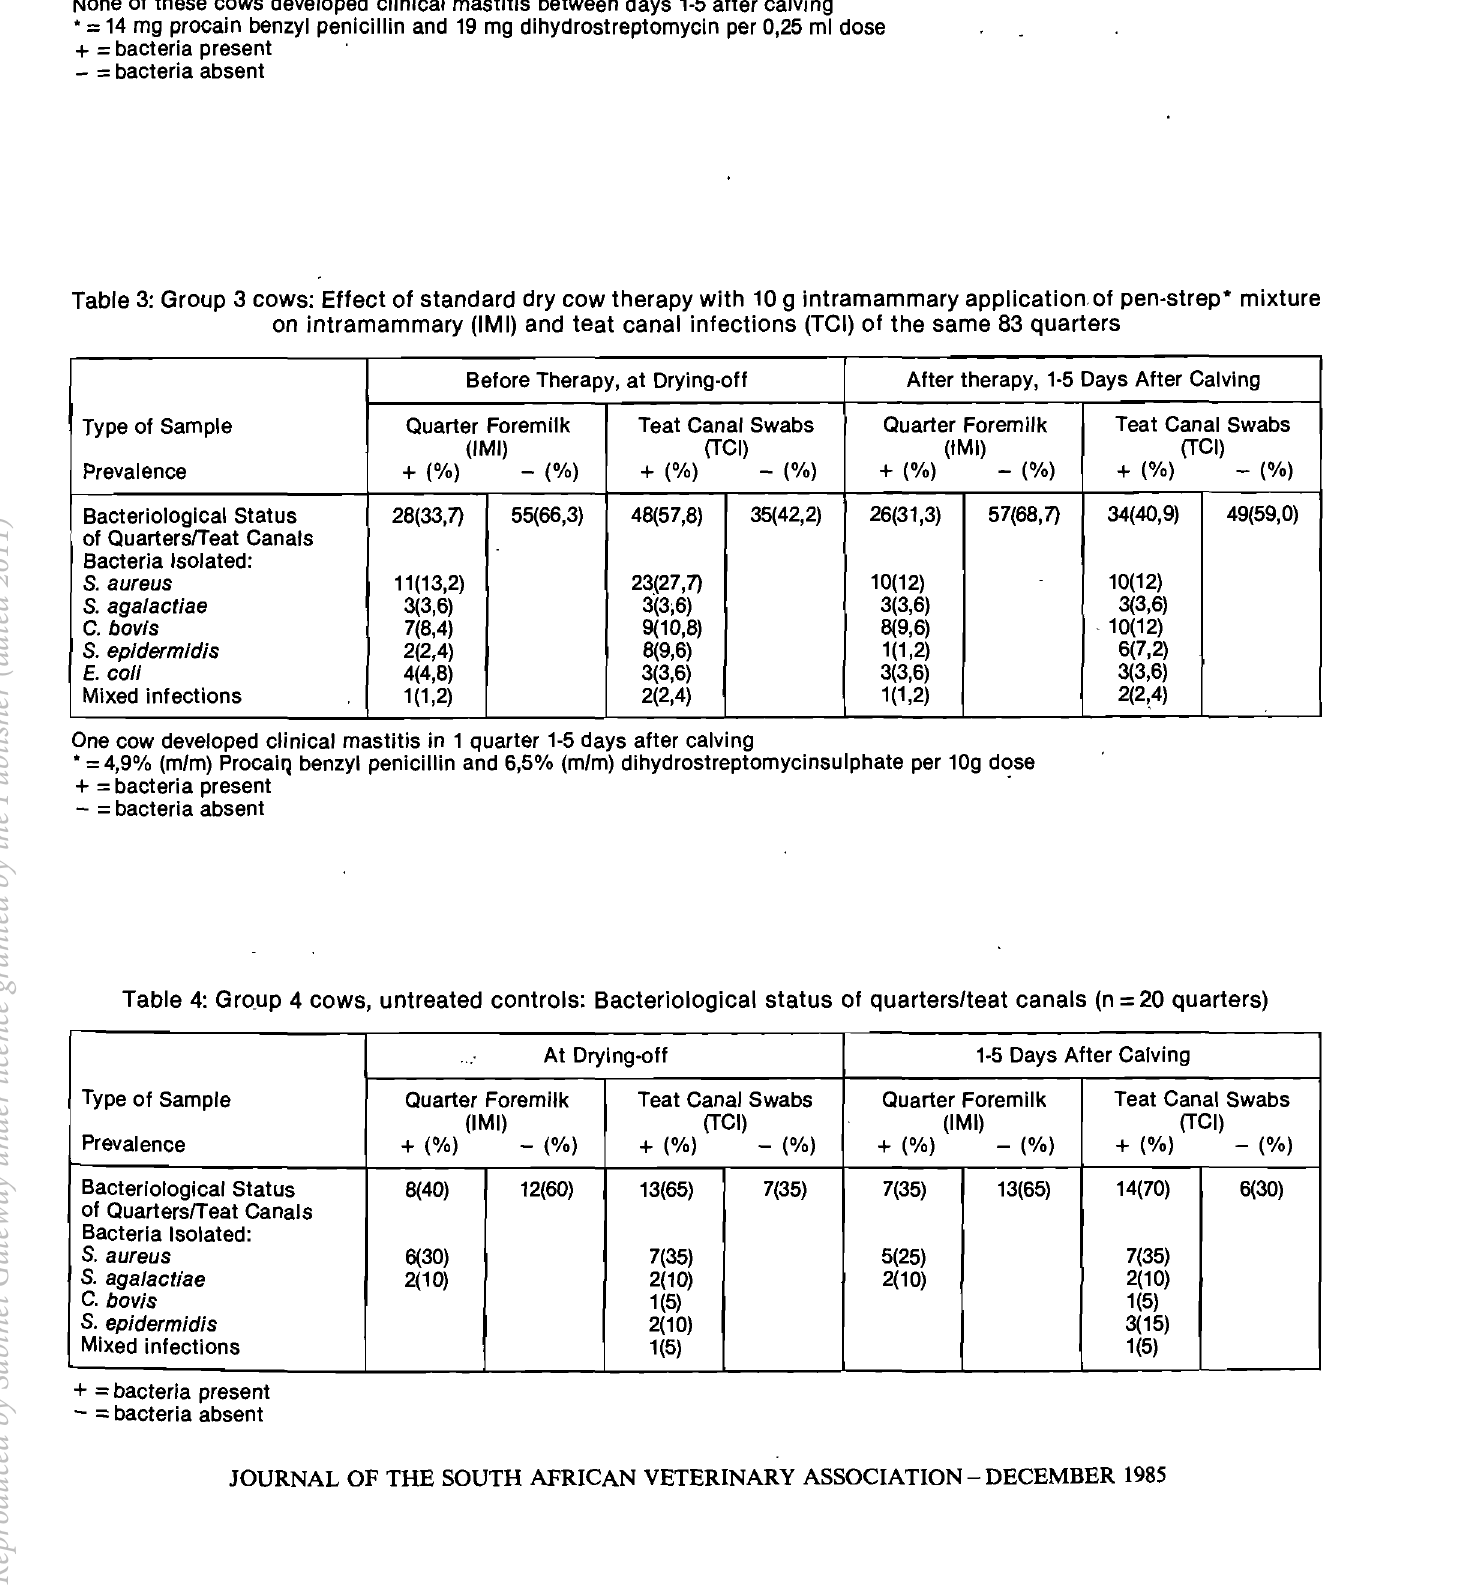
Table 3: Group 3 cows: Effect of standard dry cow therapy with 10 g intramammary application of pen-strep· mixture on intramammary (IMI) and teat canal infections (TCI) of the same 83 quarters